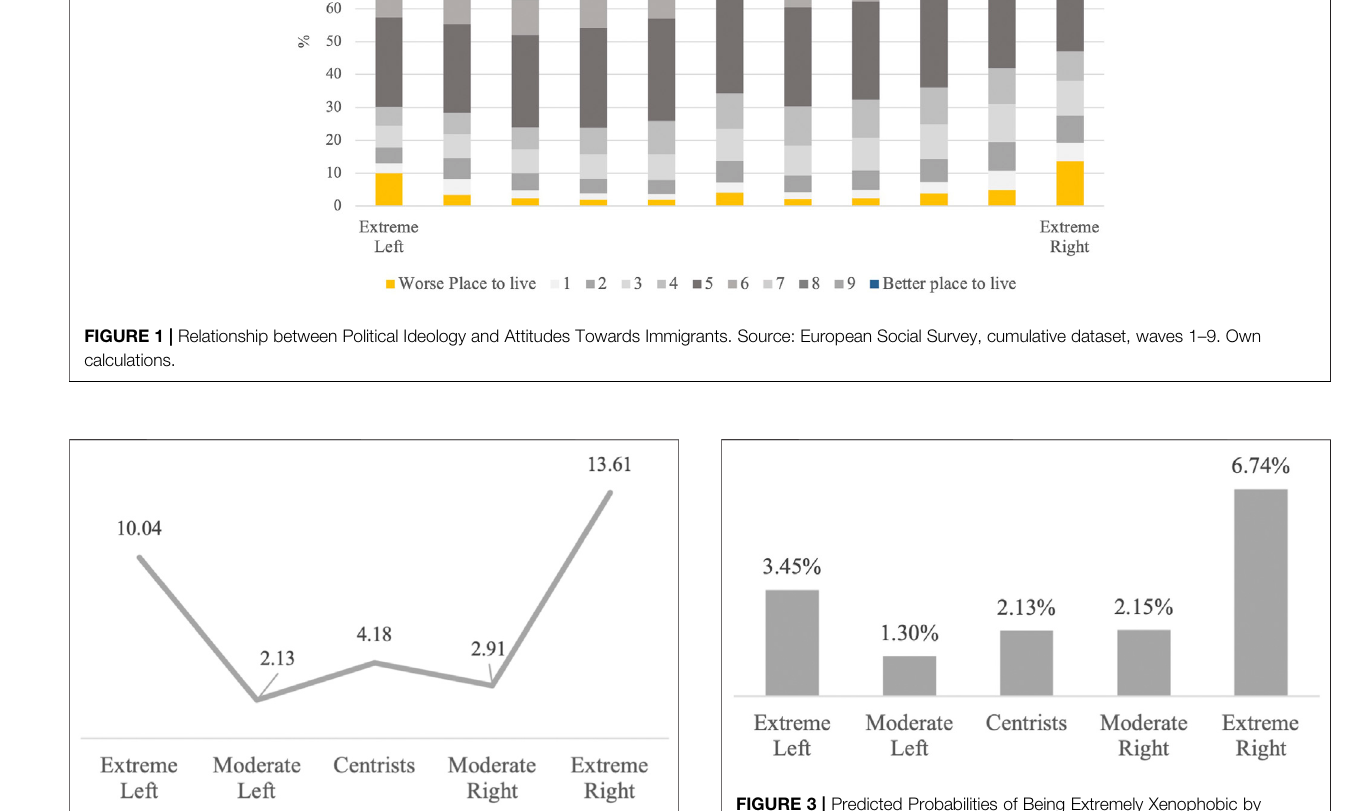
FIGURE 2 | Percentage of Extremely Anti-Immigrant Respondents by PoliticalIdeology.Source:EuropeanSocialSurvey,cumulativedataset,waves 1 – 9. Own calculations.